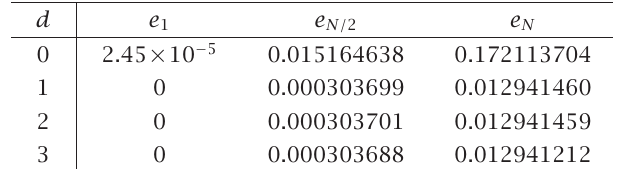
Table 4.2 . Approximate error when m = 3 and ( { c (uniformly distributed collocation parameters).